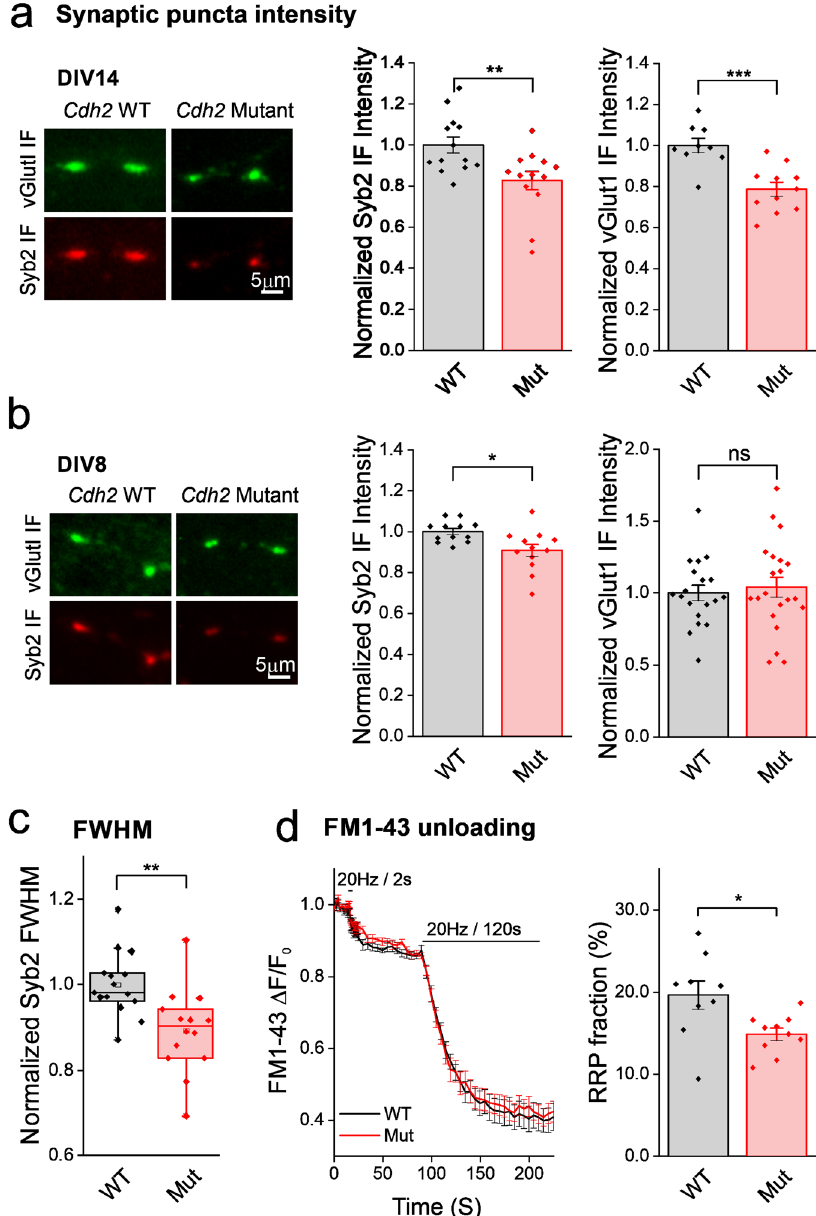
Fig. 5 Cdh2 mutation decreases synaptic vesicle cluster size in presynaptic terminals. a Left: hippocampal neurons from WT and Cdh2 H150Y mice were immunostained at 14 DIV for Syb2 (red) and vGlut1 (green). Right: mean ± SEM density of synaptic vesicles (SVs) within presynaptic terminals. Only synapses negative for GAD6 were included (Syb2: n = 13 images; vGlut1: n = 9 and 11 images, respectively, >500 boutons analyzed per image, two-sided Student ’ s t -test, ** p = 0.007, *** p = 3E − 4 ). b Same as in A for 8 DIV (Syb2: n = 12 and 13; vGlut1: n = 19 and 21 images, respectively, >500 boutons analyzed per image, two-sided Student ’ s t -test, * p = 0.01, ns p = 0.65). c Quantifying the distribution of the Syb2 fl uorescence in the synaptic puncta at rest by measuring their FWHM. Symbols represent single image FWHM; bars, 10 – 90% percentiles; box, 25 – 75% percentiles; middle bar, median ( n = 15 and 14 images, respectively, >30 boutons analyzed per image, two-sided Student ’ s t -test, ** p = 0.002). d Progressive unloading of FM1-43 dye by electrical stimulation delivered at 20 Hz for 2 s, followed by a minute of recovery and then stimulated again for 120 s at 20 Hz. Left: mean ± SEM Δ F/F 0 traces. Right: quanti fi cation of the readily releasable pool (RRP) fraction (percentage from the total release, n = 9 and 10 experiments, respectively, >30 boutons analyzed in each experiment, two-sided Student ’ s t -test, * p = 0.017). DIV, days in-vitro; FWHM, Full Width at Half